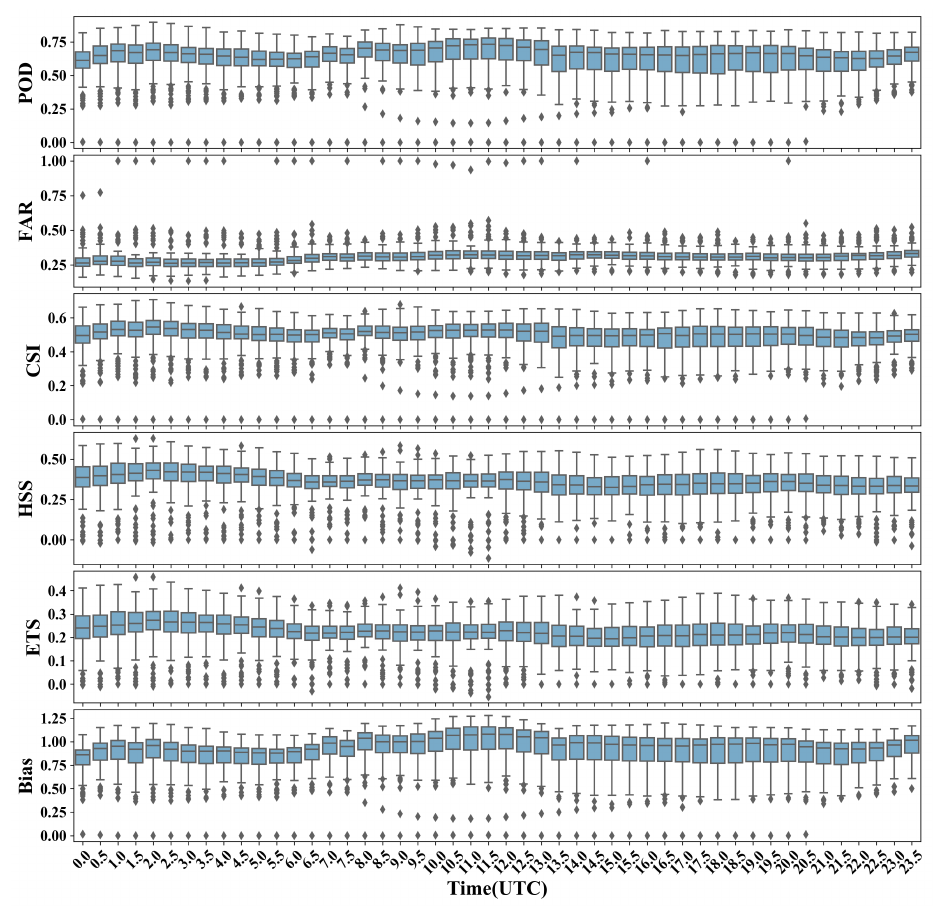
Figure 7. The diurnal variation of evaluation scores for rain area determination in the testing dataset in summer 2019; the distributions of the statistical values by half-an-hour are interpreted in box plots. Box diagrams indicate the 25th, 50th, and 75th percentiles, whereas the periphery of the box extends to 1.5-times the quartile deviation (25th–75th percentile). Outliers are indicated by black dots.